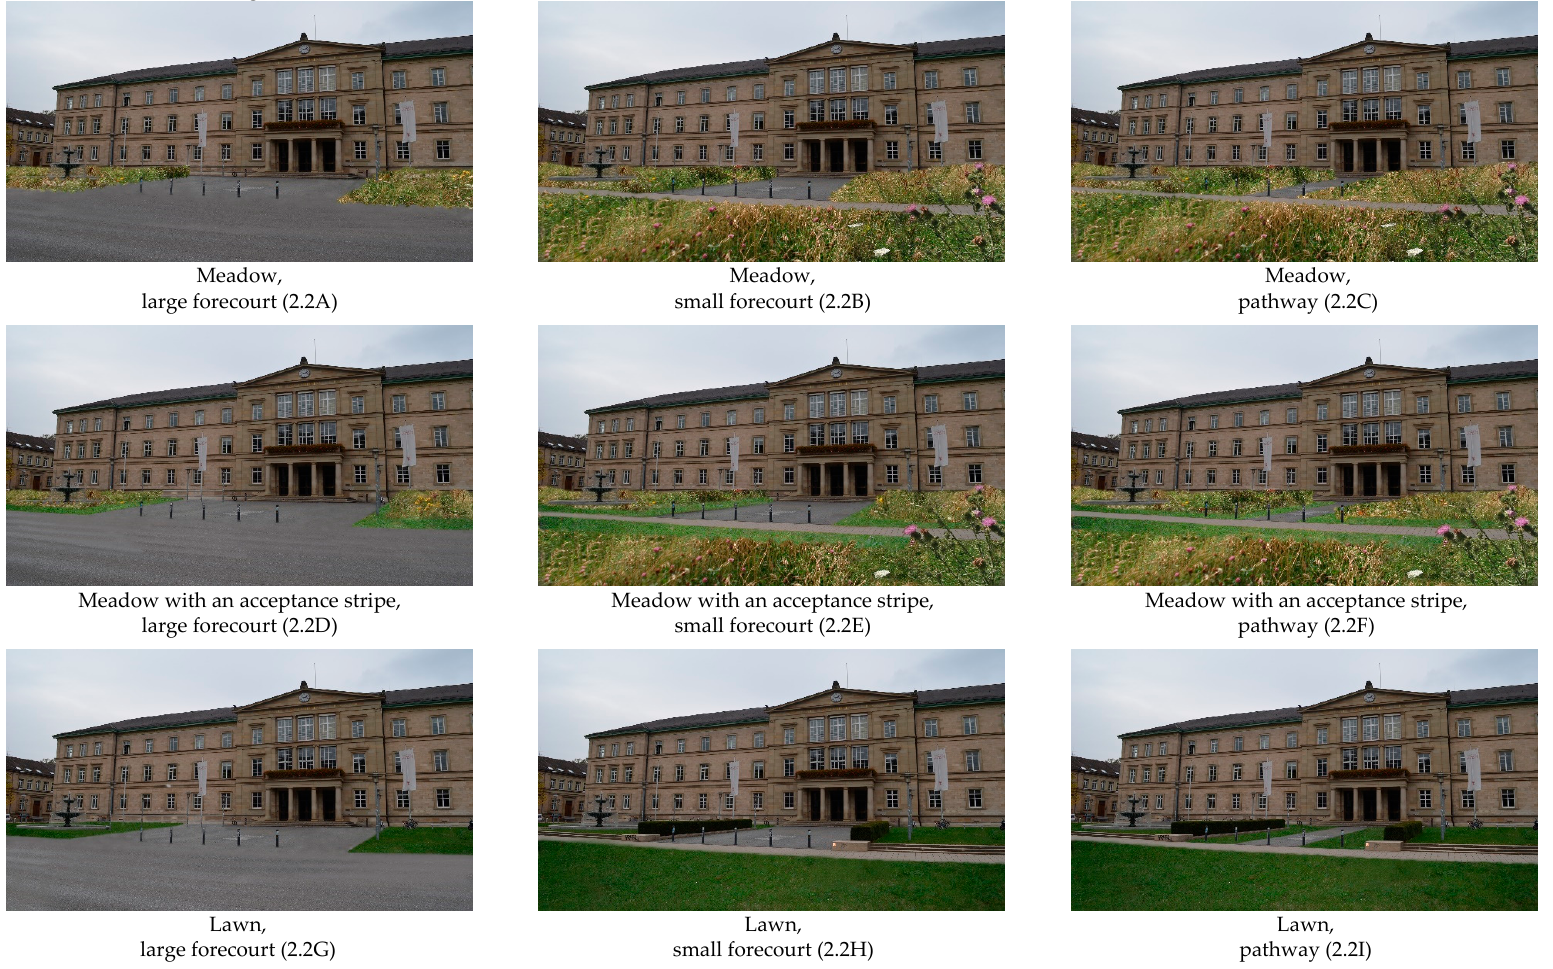
Figure 3. The aim of Question 2.2 was to establish the existence of a preference for a certain type of green space or a preference for the relative area of asphalt in relation to the green area. For further explanations, see text.